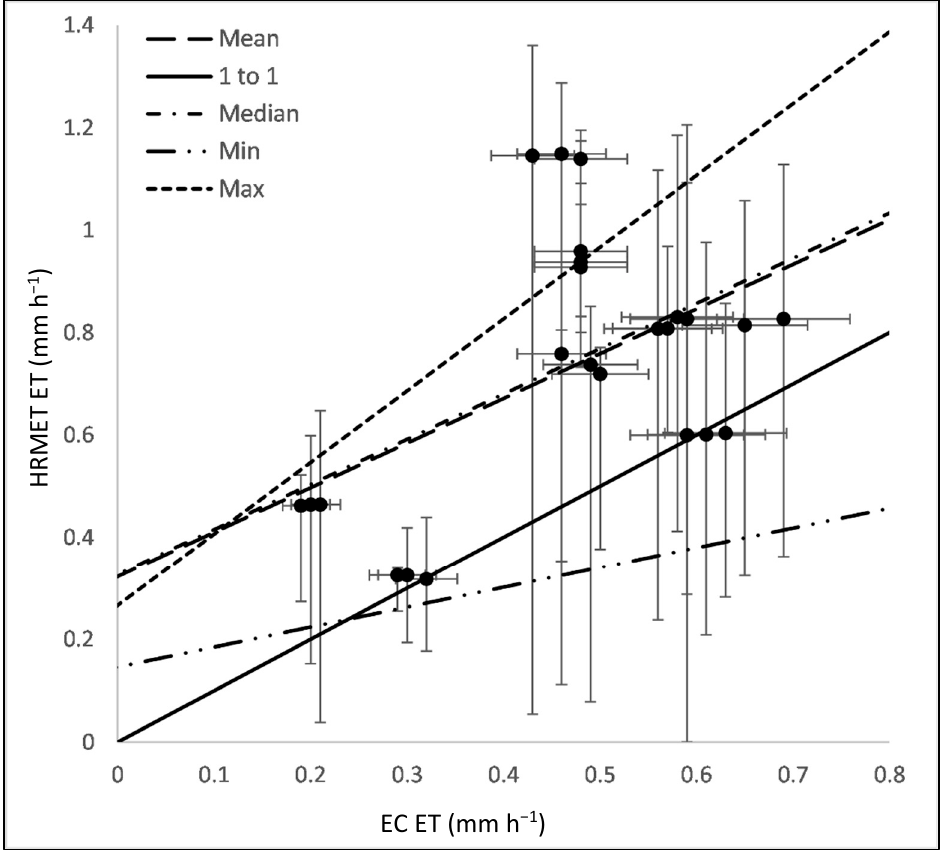
Figure 12. HRMET and EC ET regression between every flight mission from the 2019 growing season. One-to-one line added as reference to the plots. Slope, y-intercept, R 2 and RMSE were calculated for the mean, median, minimum, and maximum HRMET ET values. Table 4. Slope, y-intercept, R 2 , and RMSE values for the HRMEY and EC ET regression. Slope